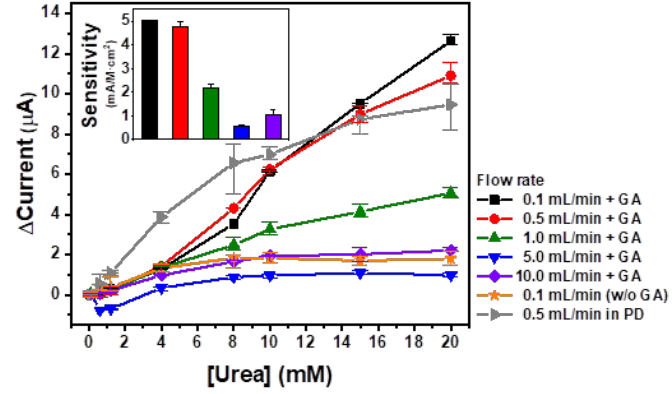
Figure 5. The real-time monitoring of urea concentration with various flow rates by the urease- immobilized SF-membrane-based urea biosensor.